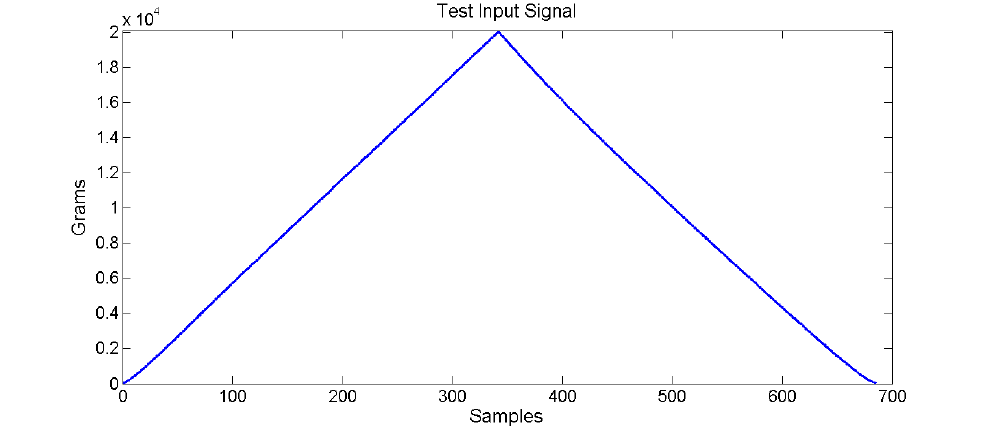
Figure 10. Input signal applied to the pressure sensor at